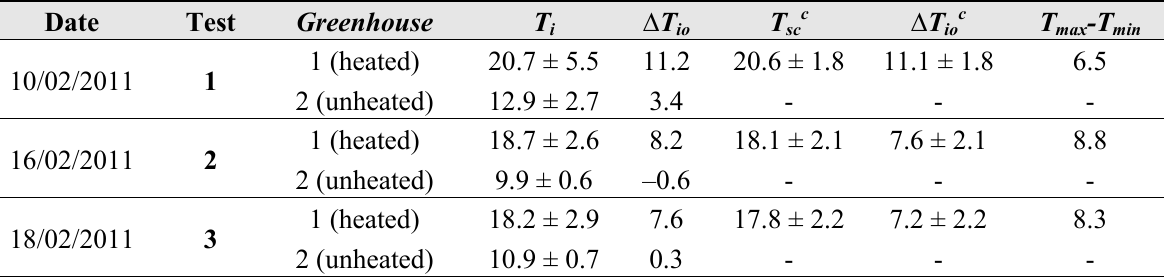
Table 3. Inside climatic conditions. At a height of 2.0 m measured with an EKTRON